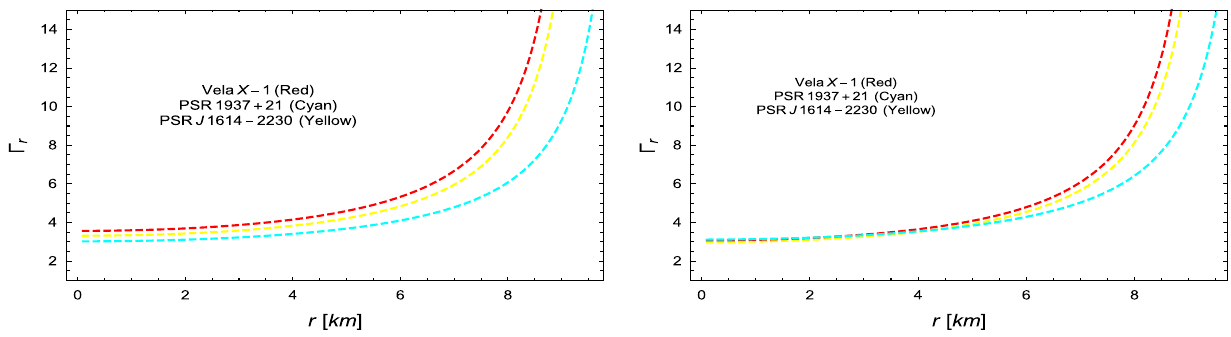
Fig. 8 Shows the variations of adiabatic index (left panel for 1st solution and right panel for 2nd solution) with respect to r , for the new anisotropic solutions figuration (more dense region) towards the stellar surface of the star (less dense region). It indicates that our anisotropic solutions are physically